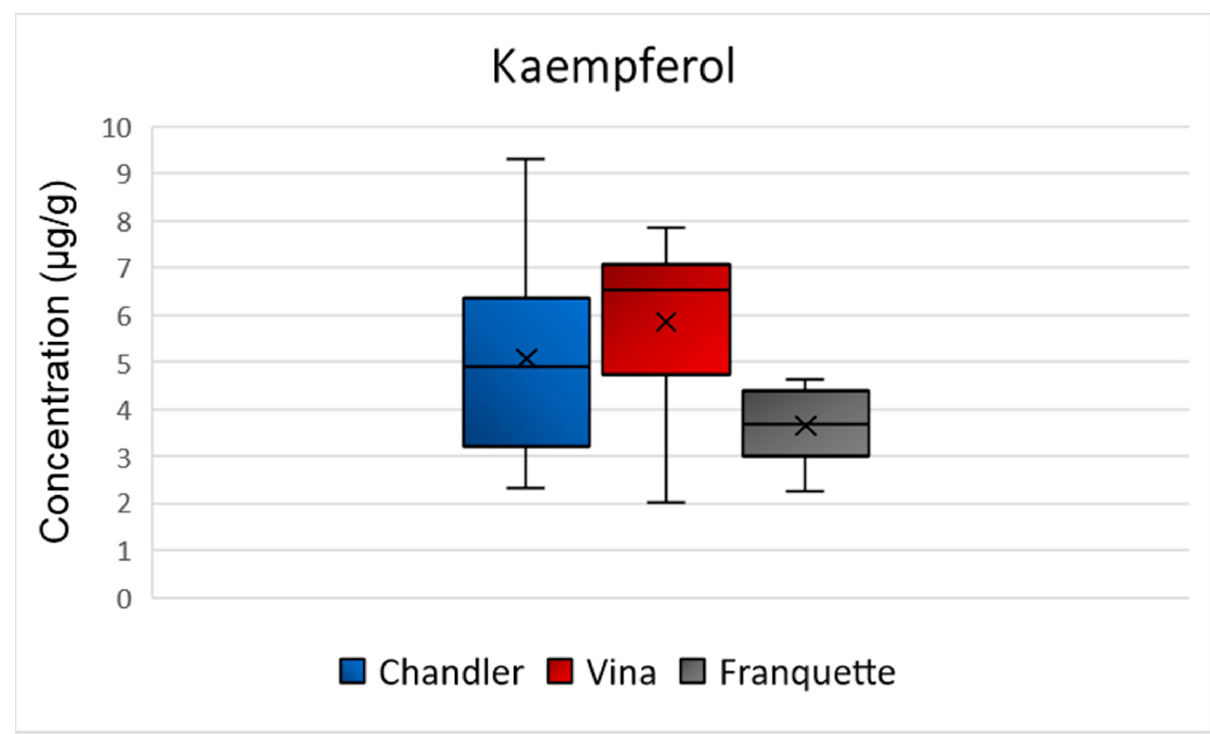
Figure 8. Box and Whisker plot for the concentration of kaempferol among walnut septa belonging to the Chandler, Vina, and Franquette varieties.